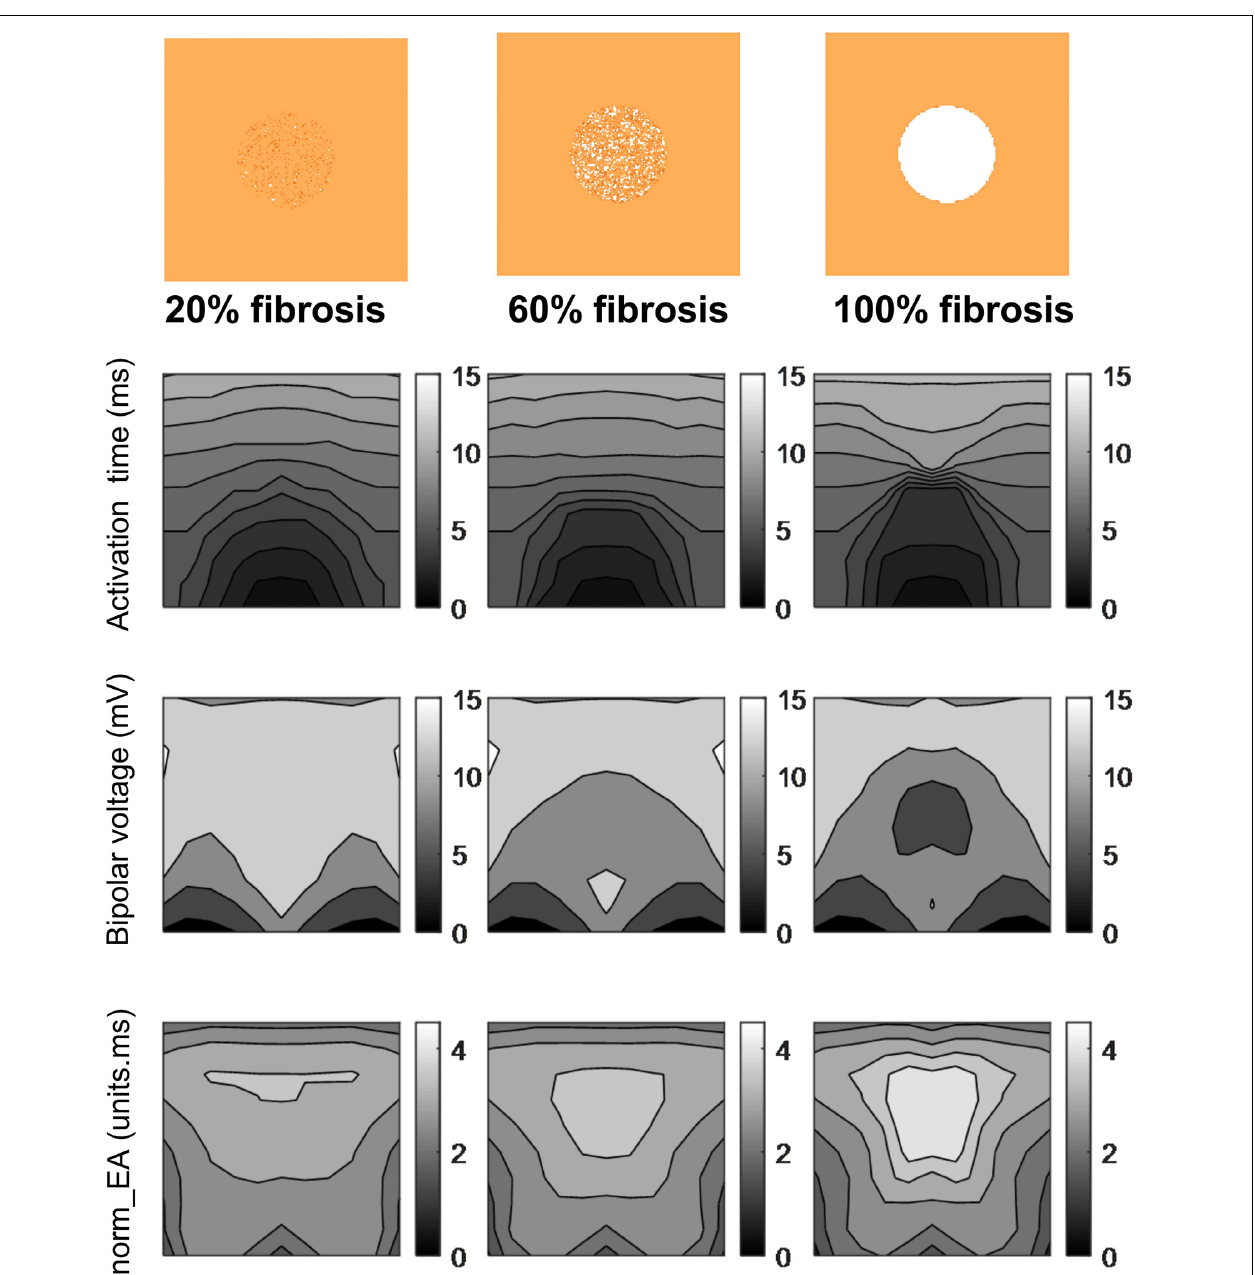
FIGURE 6 | Influence of simulated fibrosis on bipolar electrogram morphology in a model of a propagating mouse action potential (maps). Maps showing the impact of simulated regional fibrosis on the pattern of electrical activation (as analyzed from a grid of unipolar electrograms), bipolar electrogram amplitude and normalized electrogram area